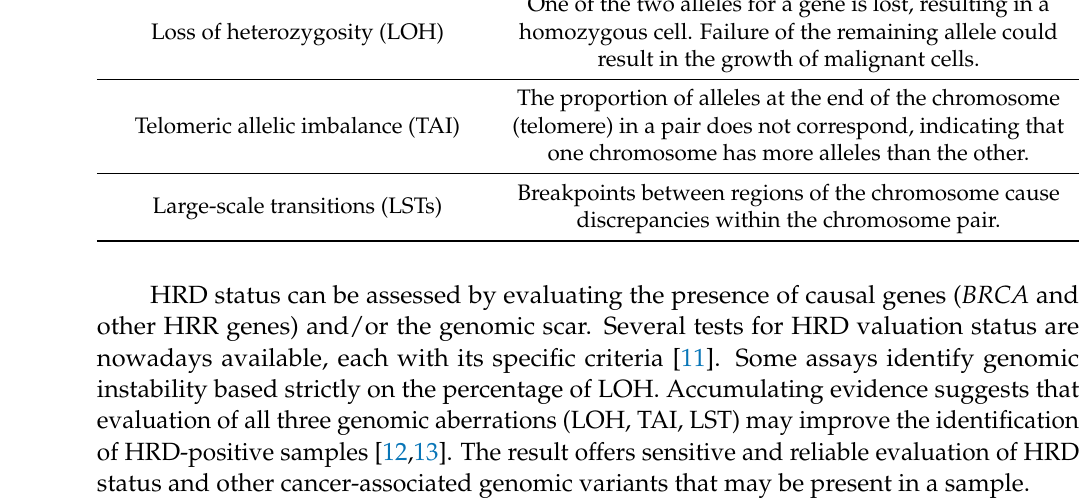
Table 2. The three genomic scars were included in a genomic instability score.